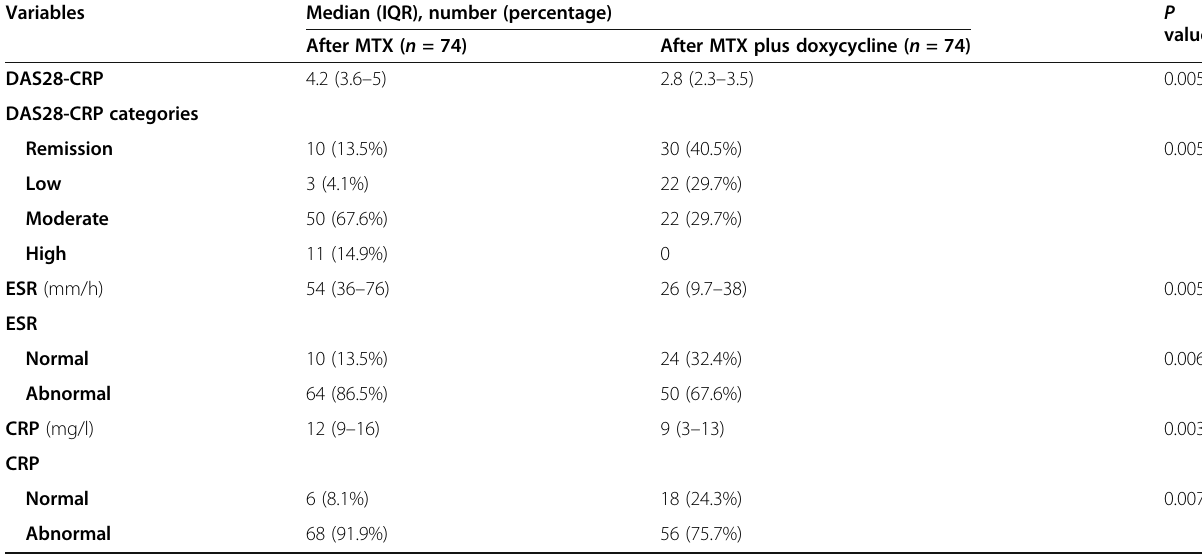
Table 4 Comparison between MTX-treated and MTX with doxycycline-treated patient groups after 3 months therapy